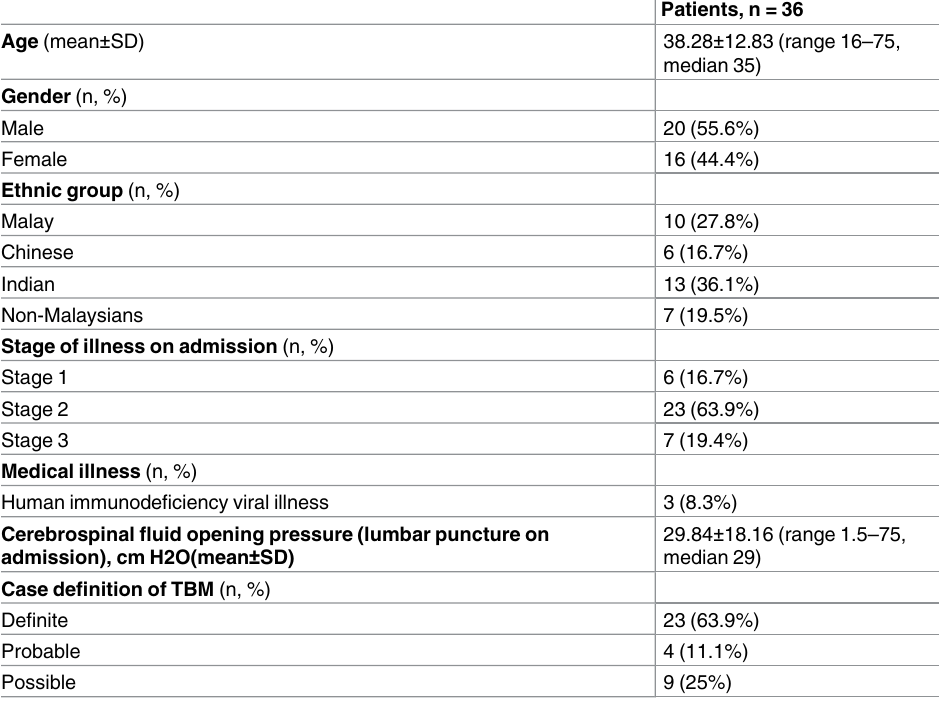
Table 1. Demography and baseline characteristics of TBM